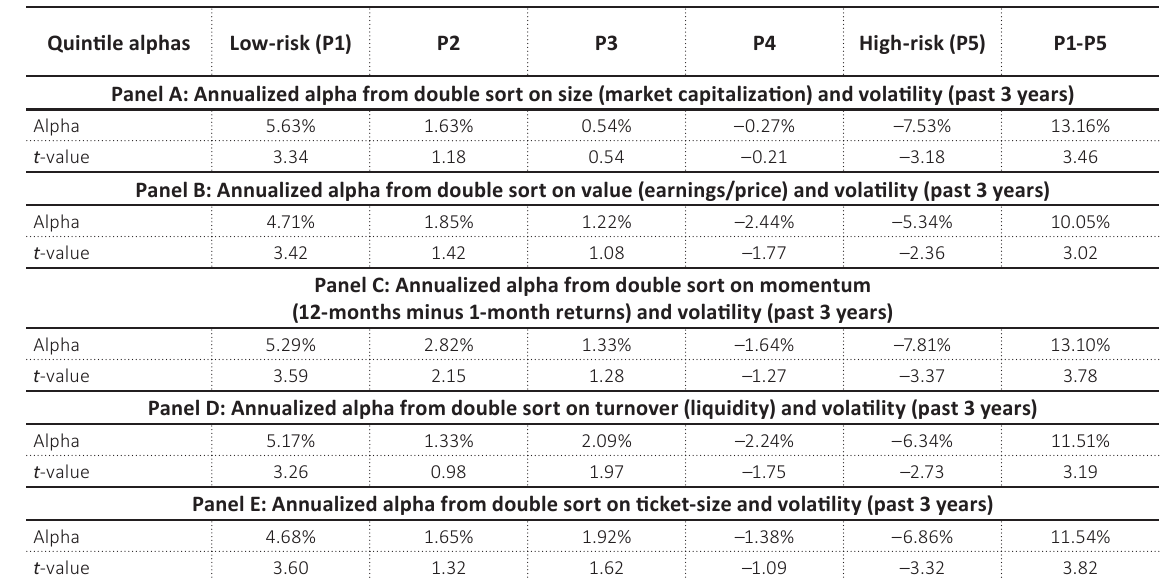
Table 3. Double- sorted results